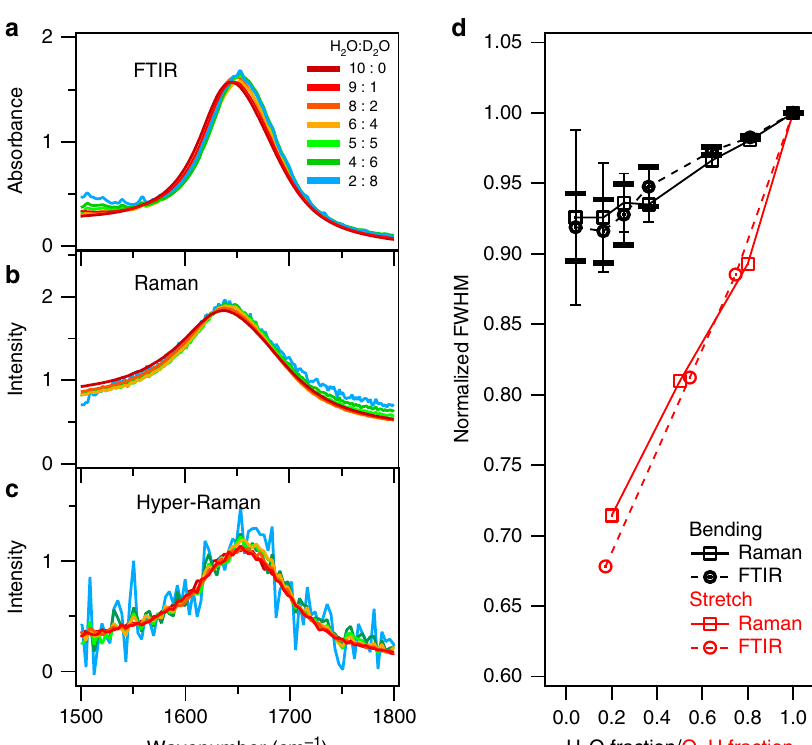
Fig. 2 The extracted H – O – H bending mode contributions. a IR, b Raman, and c hyper-Raman spectra of various H 2 O-D 2 O mixtures. d Comparison of the full widths at half maximum (FWHM) for the H – O – H bending mode contributions and the O – H stretch mode spectra. The O – H stretch IR and Raman data are extracted from refs. 49,50 , respectively. The error bars correspond to the uncertainty of the FWHMs when using the sample with the different concentration for obtaining the H – O – D bending spectrum for the background subtraction (see Supplementary Note